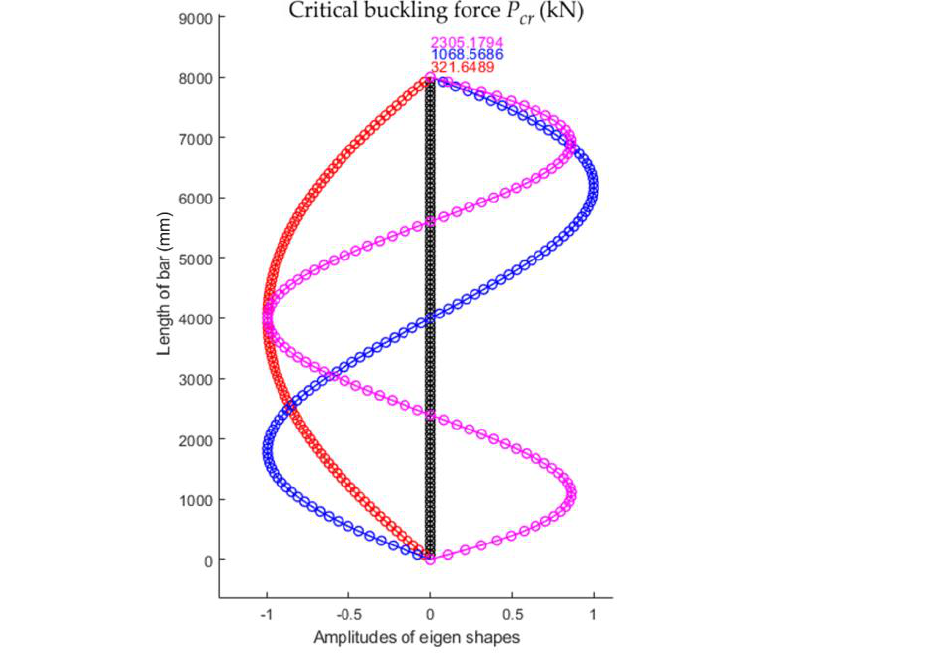
Figure 19. The first three shapes of stability loss and corresponding critical buckling forces for the bar with sinusoidal variation in the second moment of inertia along the bar axis.